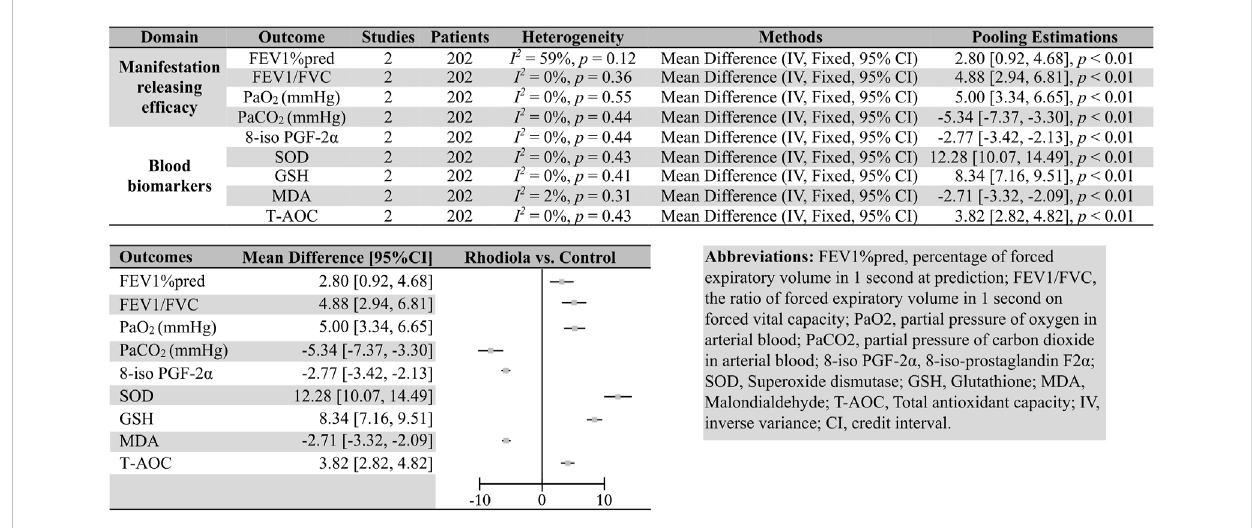
FIGURE 4 Summary of the meta-analysis results of Rhodiola vs. ambroxol in patients with